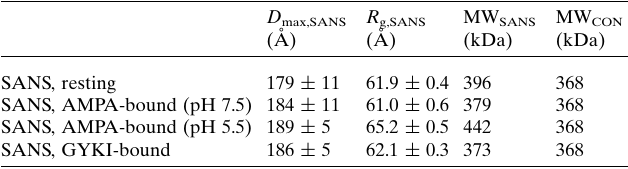
Table 1 Maximal distances, radii of gyration and molecular weights. Maximal distance ( D max ) and radius of gyration ( R g ) are as determined from the experimental p ( r ) functions ( D max,SANS and R g,SANS ) and from the theoretical p ( r ) functions ( D max,THE and R g,THE ) from the structures. Molecular weight (MW) is given based on solution SANS data (MW SANS ) determined with Fischer analysis (Fischer et al. , 2010), calculated from the sequence of the construct (MW CON ) and caluculated from the sequence of the crystal and cryo-EM structures (MW STR